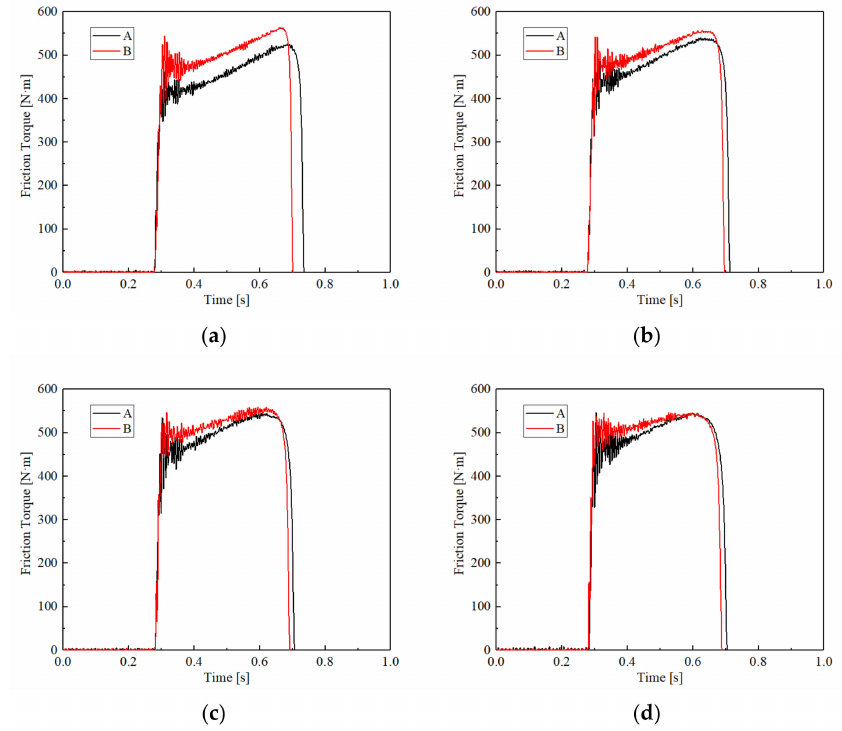
Figure 10. Variations of the friction torque at different ATF temperatures: ( a ) 60 ◦ C; ( b ) 80 ◦ C;